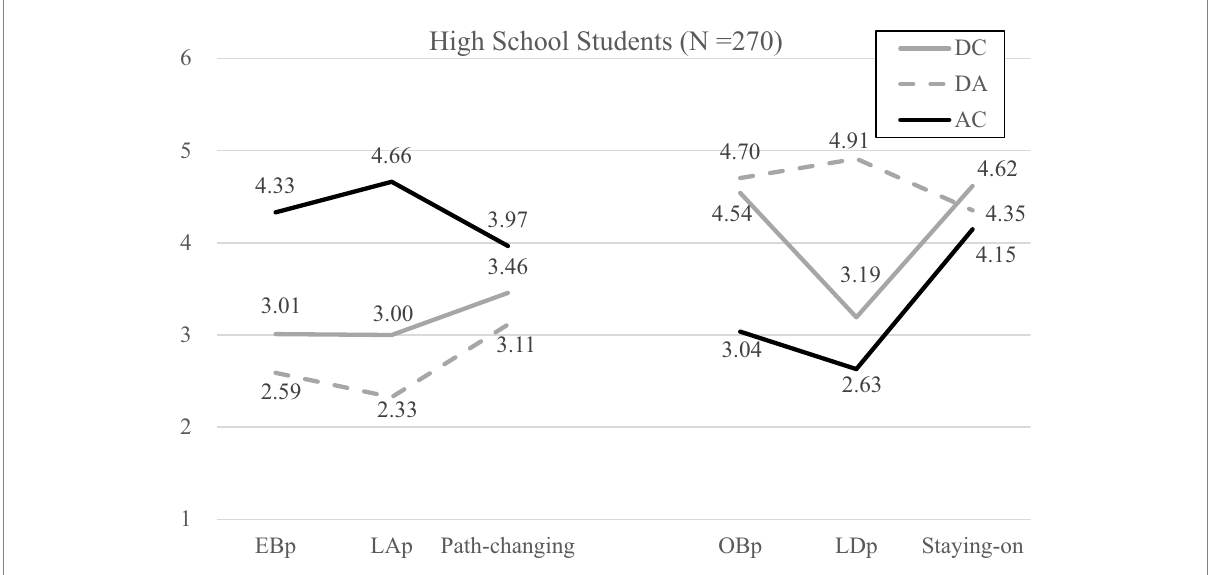
FIGURE 2 Results of profile analysis of the impact of teacher feedback on students’ perceived teacher belief, teacher attribution, and students’ behavioral intentions. EBp, Perceived entity belief; LAp, Perceived lack of ability; OBp, Perceived obligation belief; LDp, Perceived lack of duty